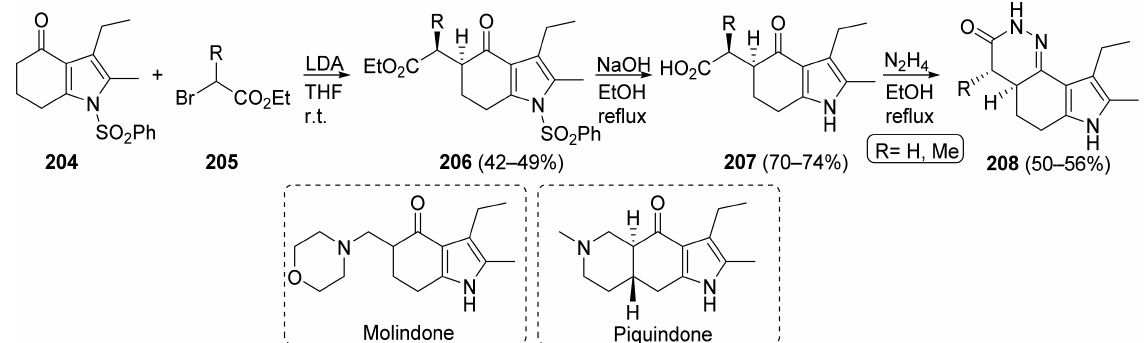
Scheme 36. Synthesis of pyrroloflavanoids as Karanjin